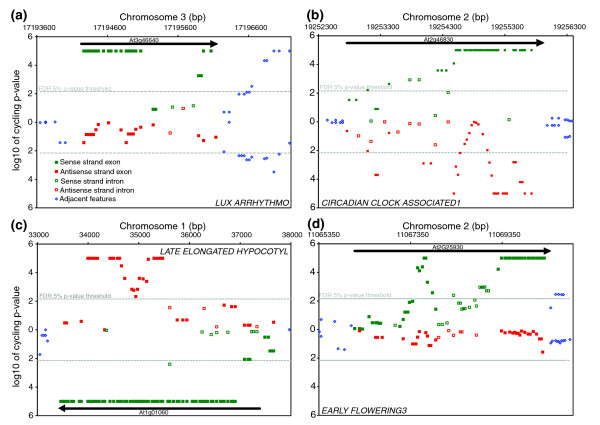
The Arabidopsis tiling arrays portray several interesting classes of circadian behavior in the genome. Each symbol is a feature on the tilling array showing location in the genome (x-axis) and significance of the spectral analysis (y-axis) for (a) LUX ARRHYTHMO, (b) CIRCADIAN CLOCK ASSOCIATED1, (c) LATE ELONGATED HYPOCOTYL, and (d) EARLY FLOWERING3. The top half of each panel displays the Watson strand and the bottom half the Crick strand. Individual features that exceed the false discovery rate 5% p-value threshold (-) are considered to have a circadian rhythm.